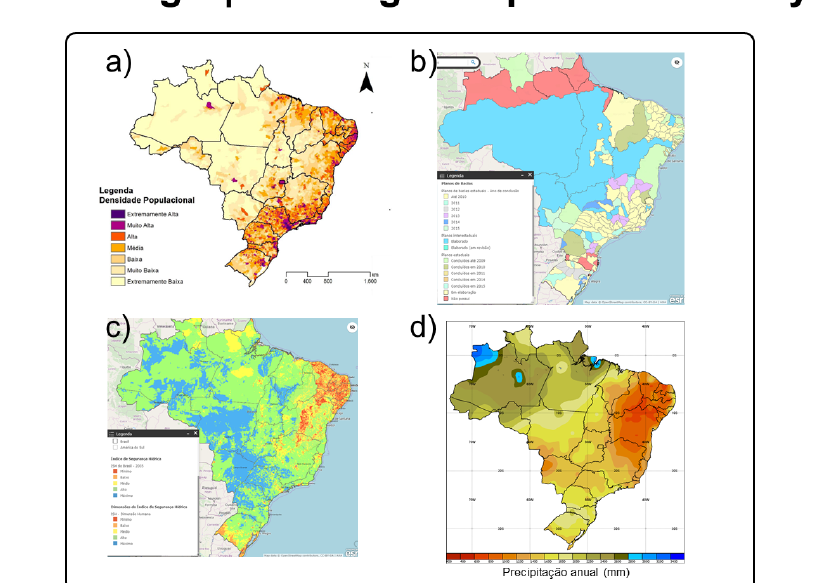
Figure A19. Package of maps used in the fourth training for mapping climate risk associated with water scarcity. The maps illustrate (a) population density (MMA, 2017), (b) stage of implementation of the water resources planning (Planos de Recursos Hídricos, 2020), (c) water security index (Planos de Recursos Hídricos, 2020), and (d) annual rainfall (Normais climatológicas do Brasil,